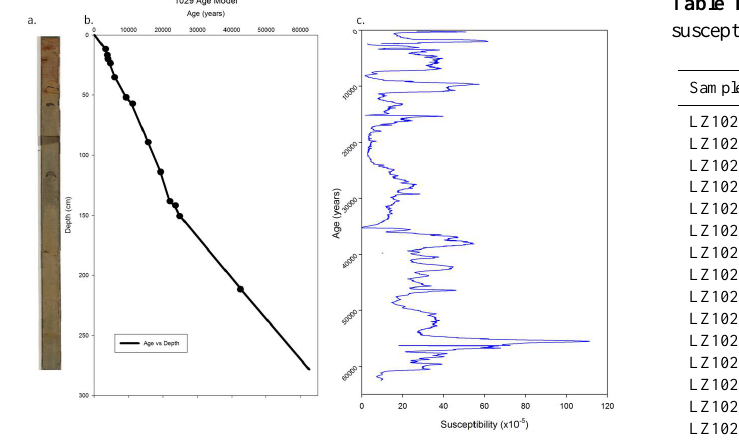
Fig. 3. Depth-age model developed for 3-m core LZ1029-7 based on linear interpolation of ages between tie points between cores LZ1029-5/8/9 and PG1351. (a) High resolution scanned image of core LZ1029-7 prior to sampling. (b) Depth-age model for core LZ1029-7. Correlation between cores was based on sedimentology and stratigraphic markers (e.g. turbidites, ash layer) and fluctuations in the TOC and bulk 13 C org data. Tie points are marked by black circles. (c) Magnetic susceptibility ( κ) of LZ1029-7.